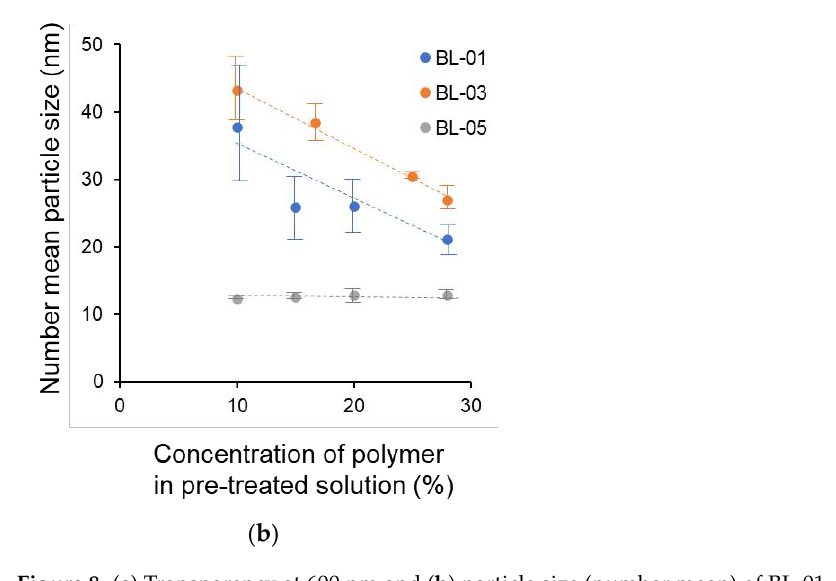
BL-05 alkaline solution with various concentrations in pre-treated solution. alkaline solution with various concentrations in pre-treated